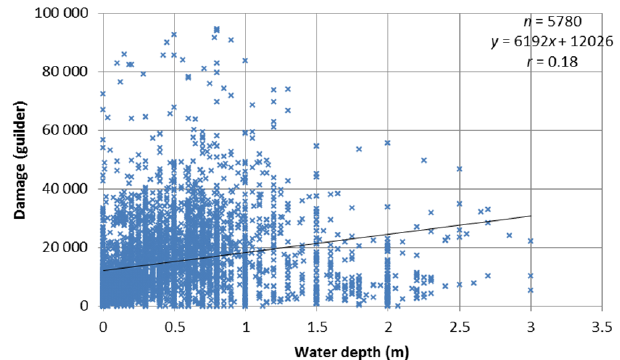
Figure 1. Scatter plot showing the relation between water depth and damage in the original data